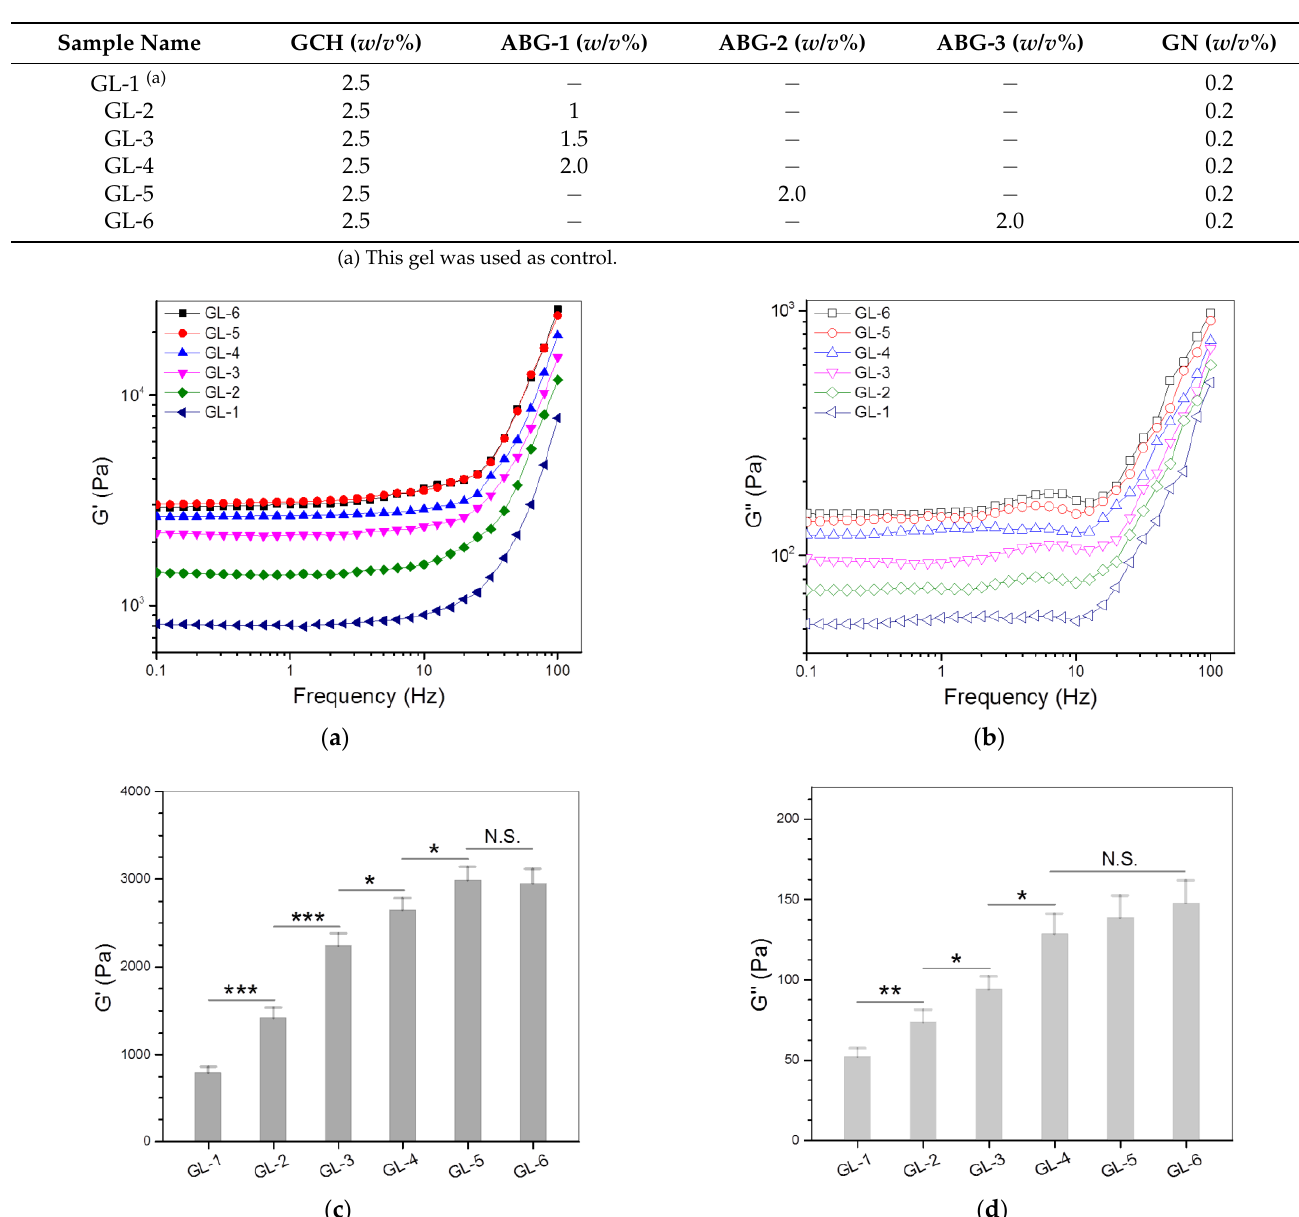
Table 2. Parameters for single-crosslinked hydrogels.